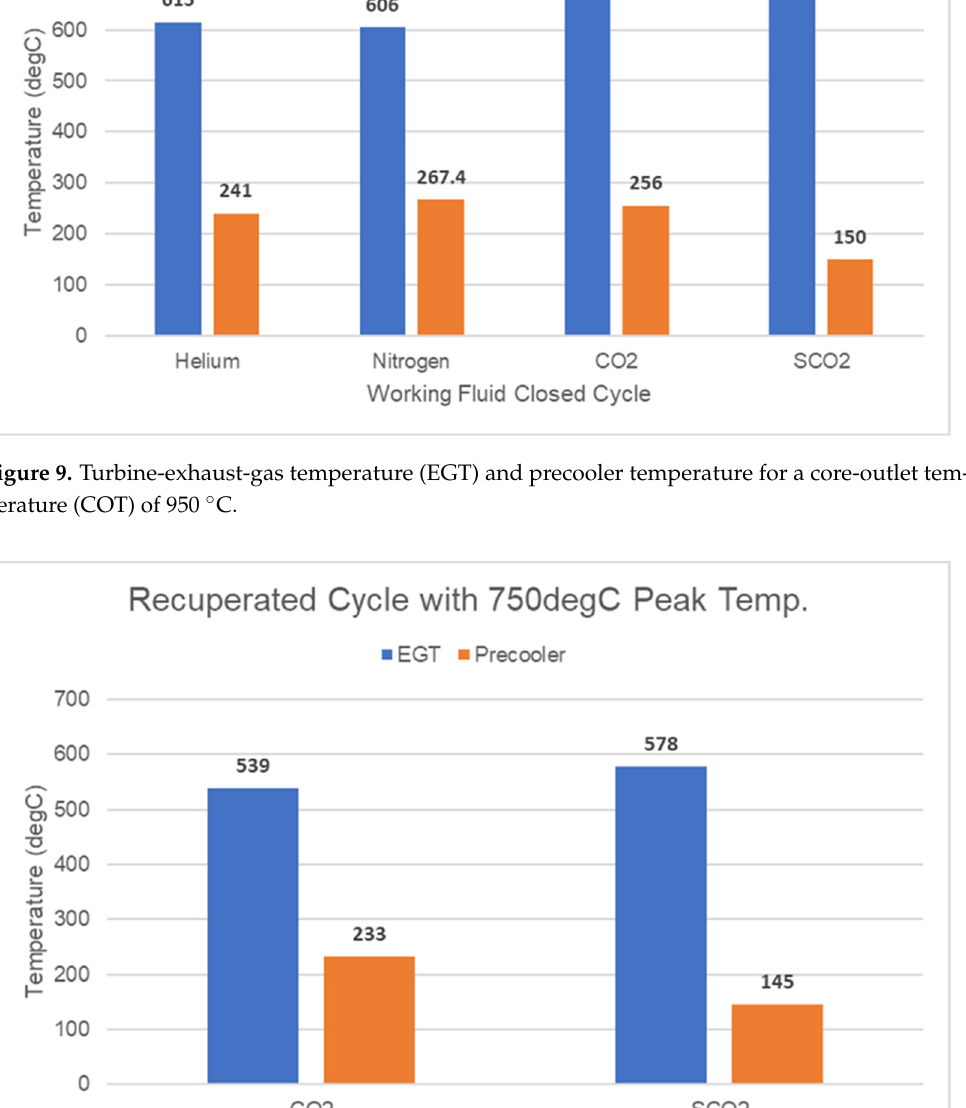
Figure 10. Turbine-exhaust-gas temperature (EGT) and precooler temperature for a core-outlet Temperature (COT) of 750 °C.